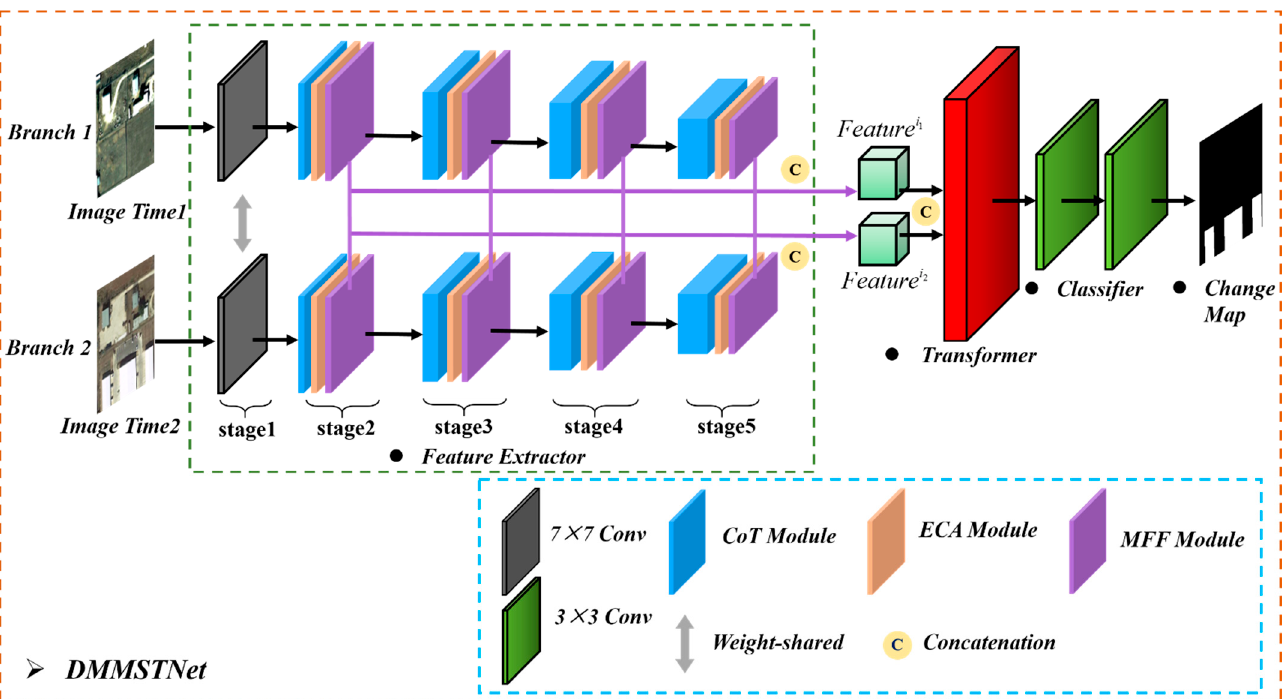
Figure 1. The architecture of the proposed DMMSTNet.